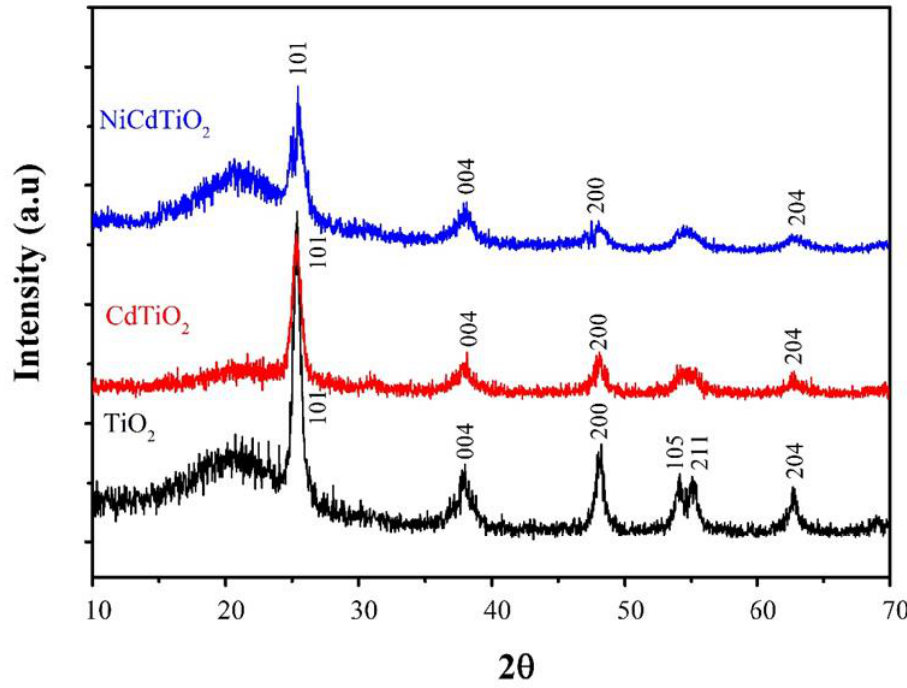
Figure 6. XRD patterns of the TiO 2 , CdTiO 2 and NiCdTiO 2 .